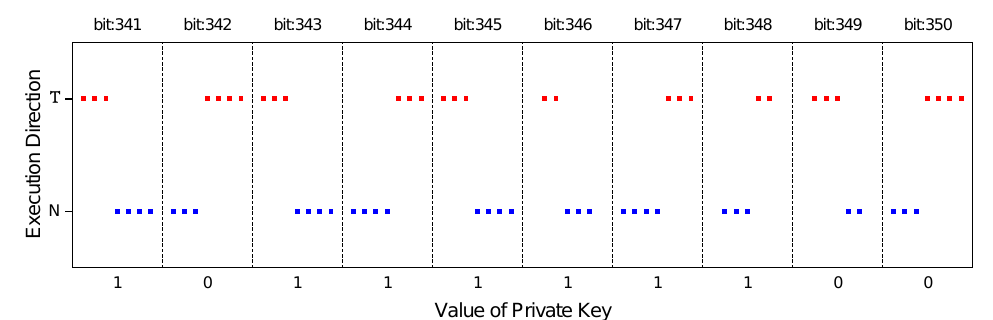
Figure 9: The TBDV-A of the attacker’s target branch during the attack against the RSA-2048 decryption algorithm in mbed TLS.